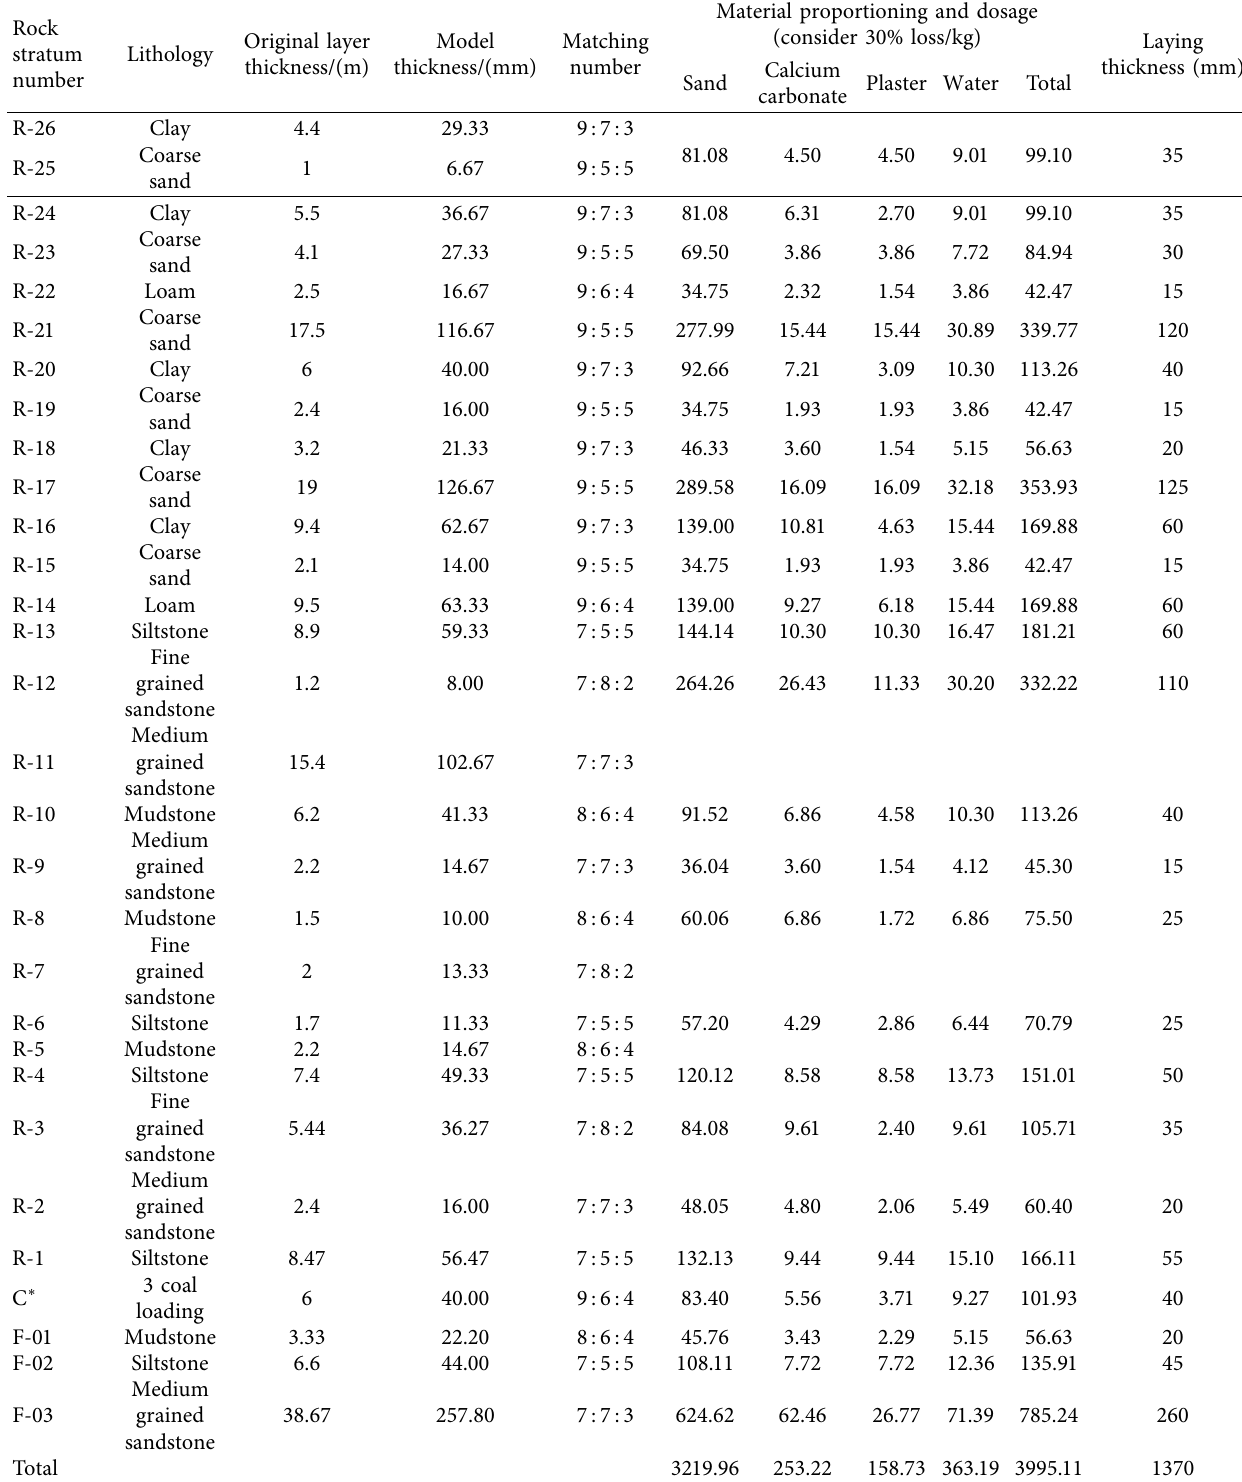
Table 2: Similar material ratios for different layers of similar material